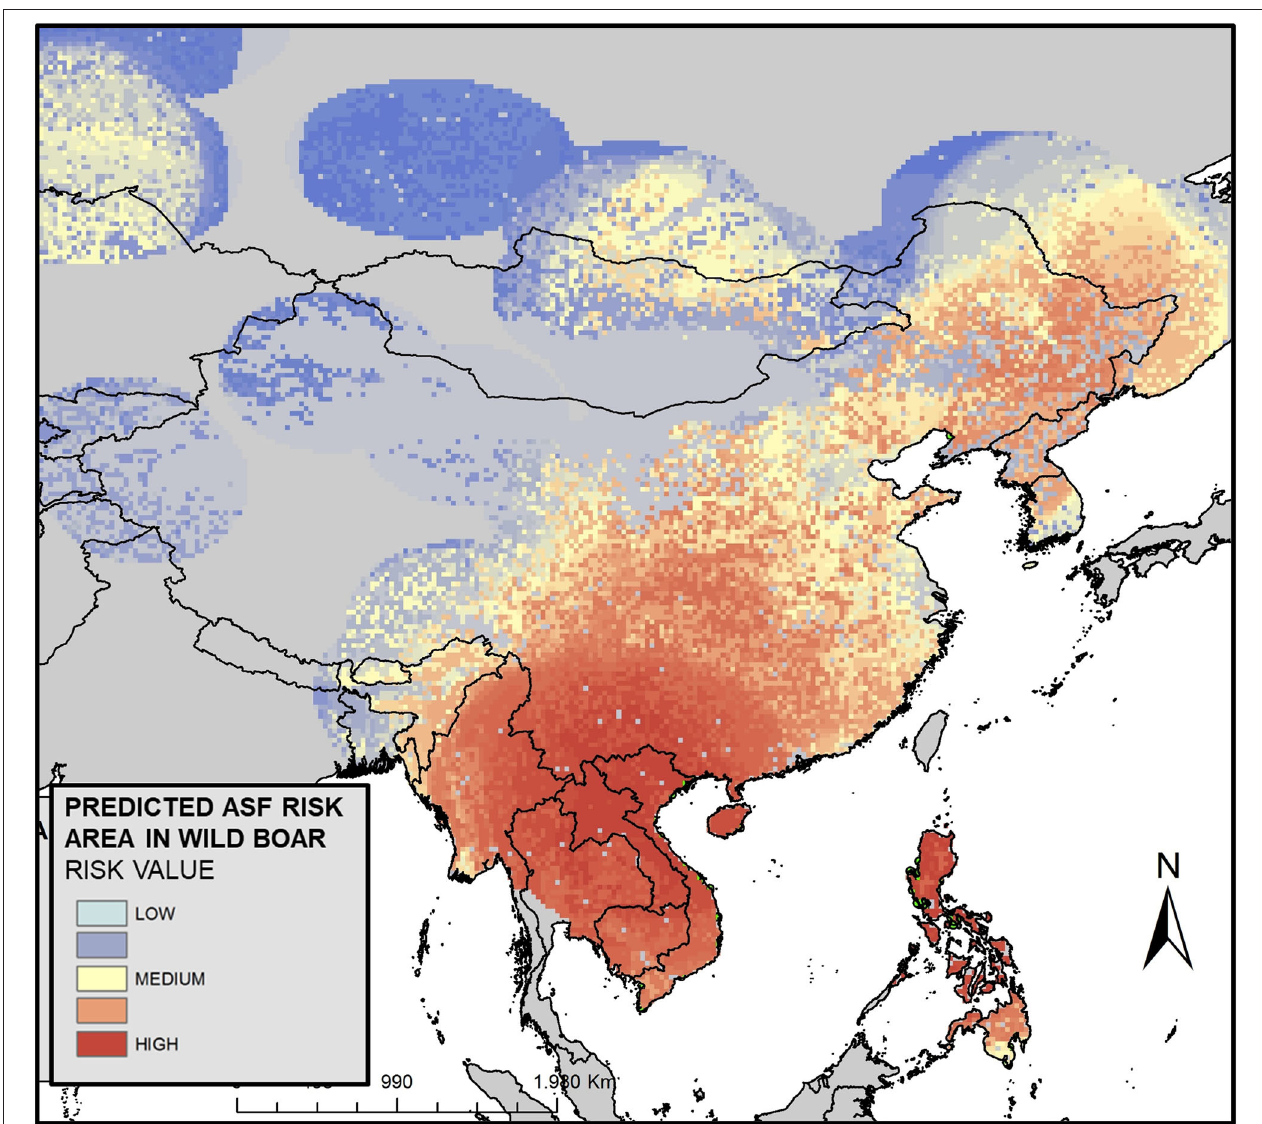
FIGURE 2 | Predicted high-, medium-, and low-risk areas of African swine fever (ASF) in wild boar in Asia (Zoom on the estimated extent of ASF virus infection in wild boar populations in South East and East